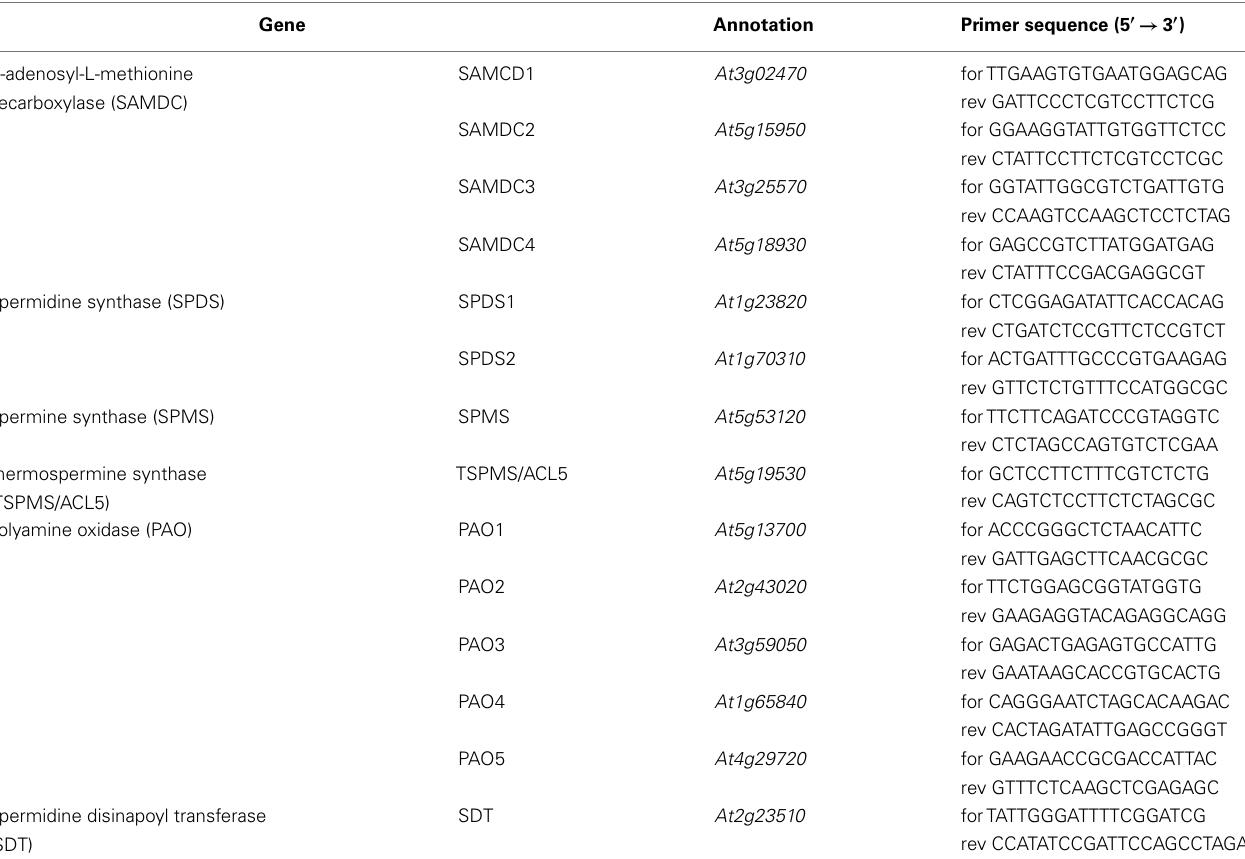
Table 2 | List of relevant polyamine biosynthetic genes in A. thaliana analyzed by transcript accumulation. Gene Annotation Primer sequence (5 (cid:48) → 3 (cid:48)